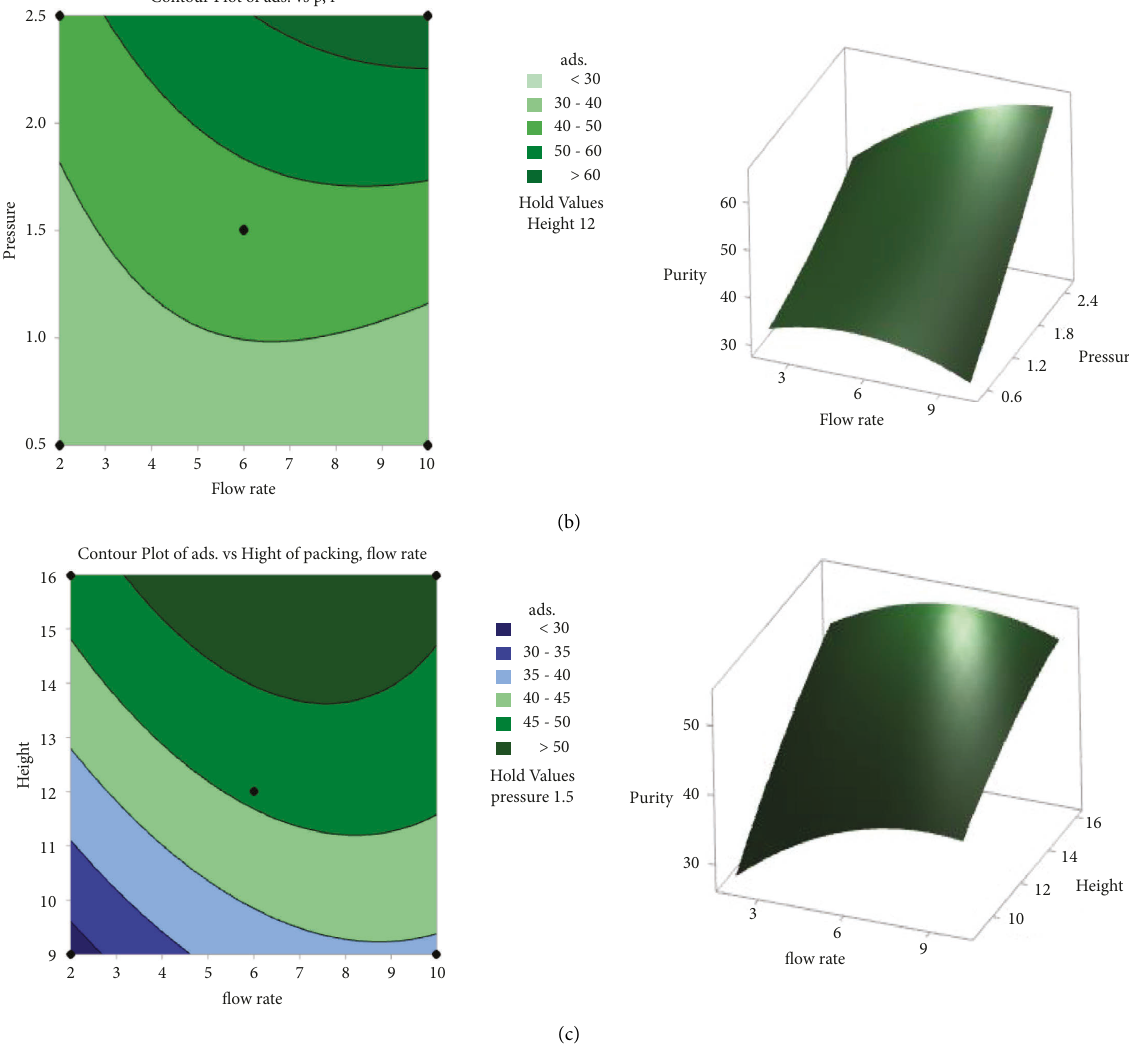
Figure 8: Response surface and contour plots for the effect of (a) pressure and height, (b) pressure and flowrate, and (c) height and flowrate on the purity of O 2 .